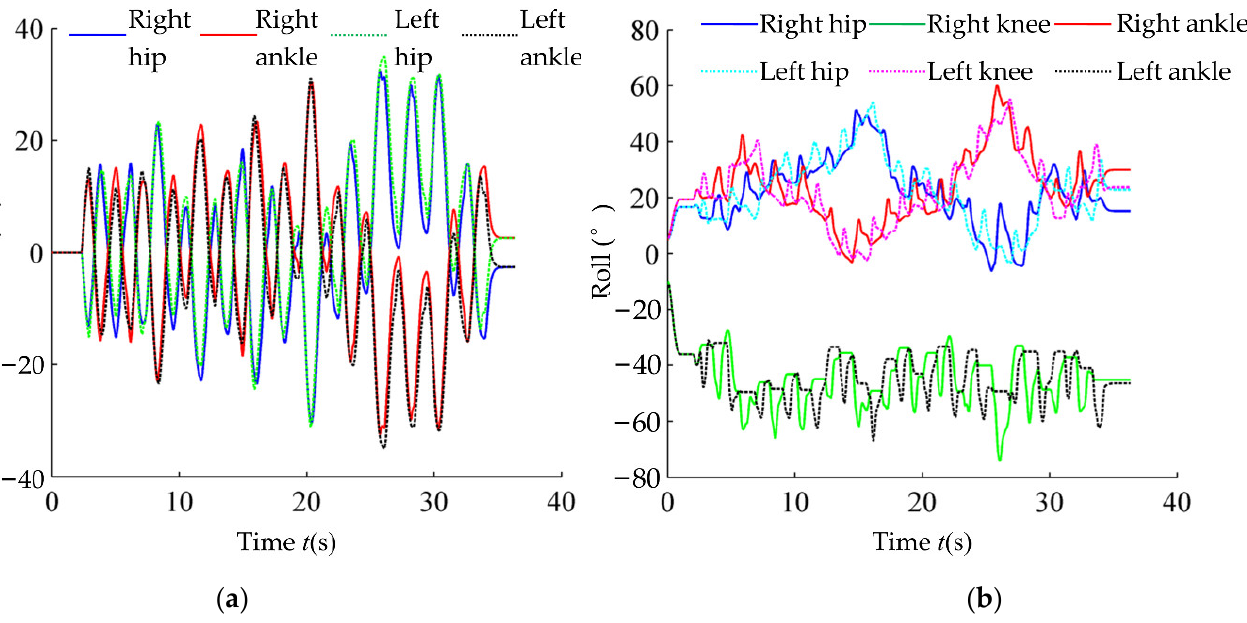
Figure 16. Joint angle in random stepping. ( a ) Roll joint angle; ( b ) pitch joint angle.